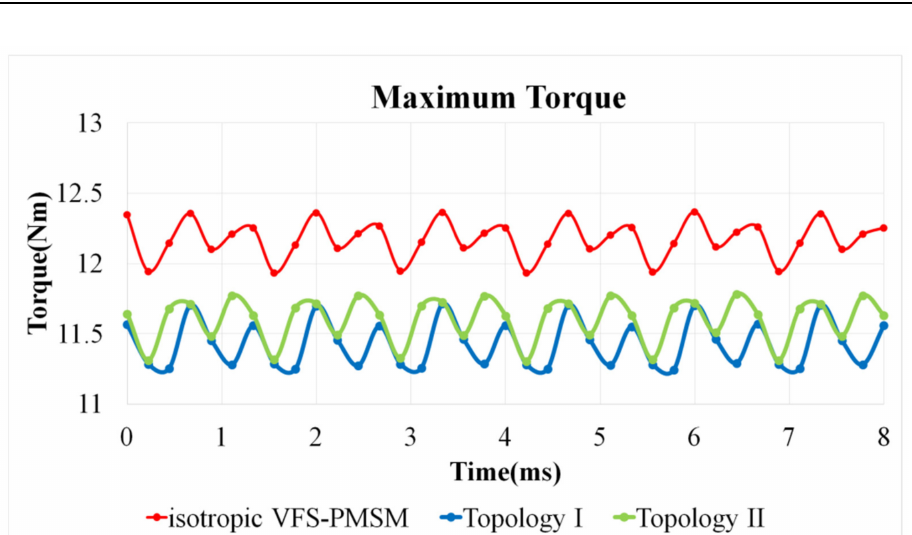
Figure 3. Maximum torque of isotropic VFS-PMSM, Topologies I and II in enhancing state obtained through Maximum Torque per Ampere (isotropic VFS-PMSM = 12.12 Nm, Topology I = 11.42 Nm, Topology II = 11.6